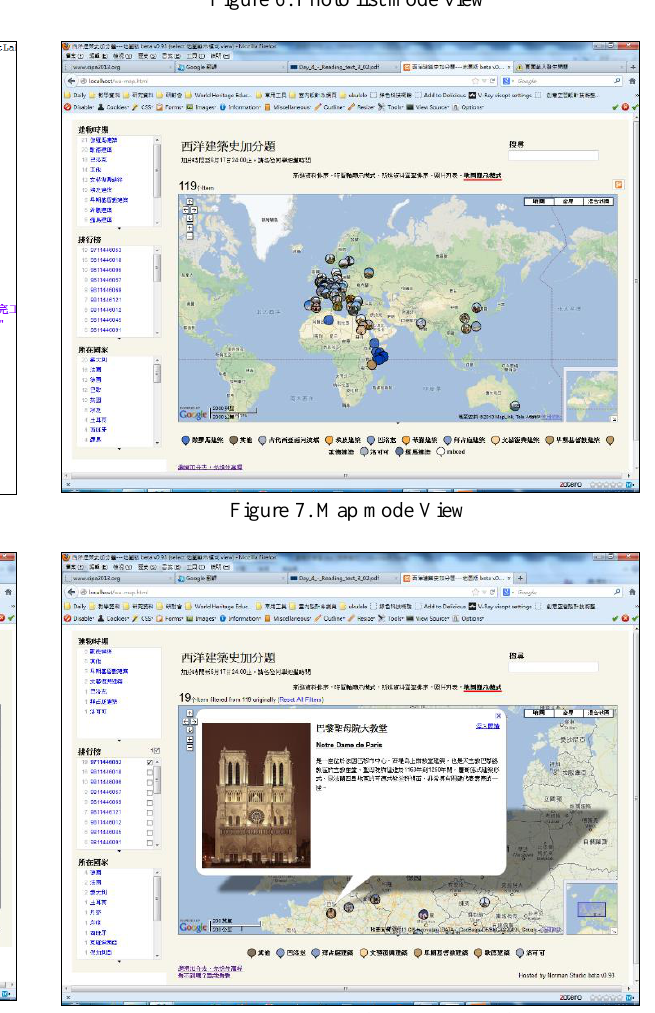
Figure 8. Popup window in map